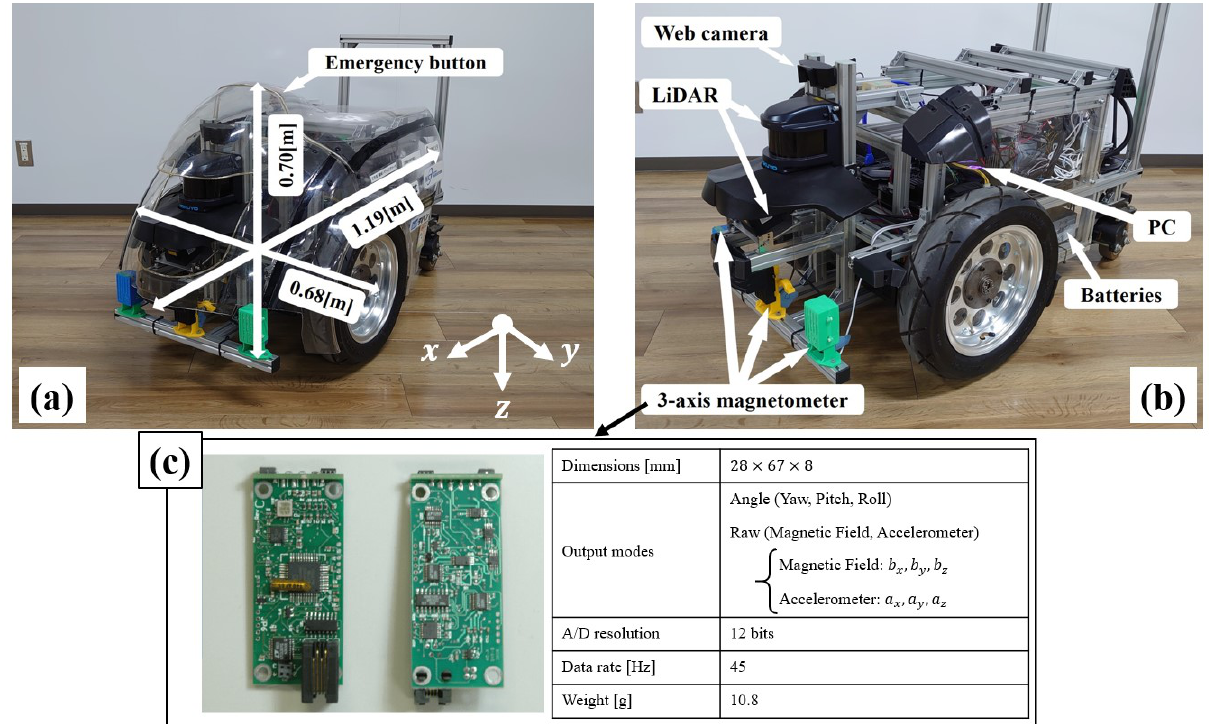
Figure 3. “MAUV”, the hardware used in the experiment. ( a ) MAUV with the cowl. The cowl was developed considering the requirements of a service robot for transporting people while ensuring safety [51]. ( b ) MAUV without the cowl. ( c ) Appearance and specifications of the magnetic sensors